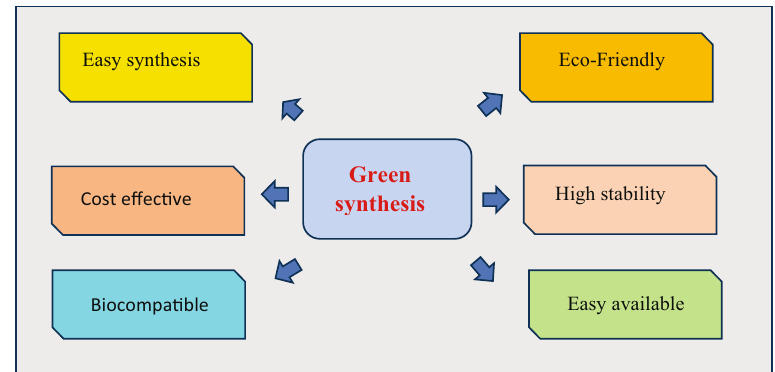
Figure 1: The main advantages of green synthesis.